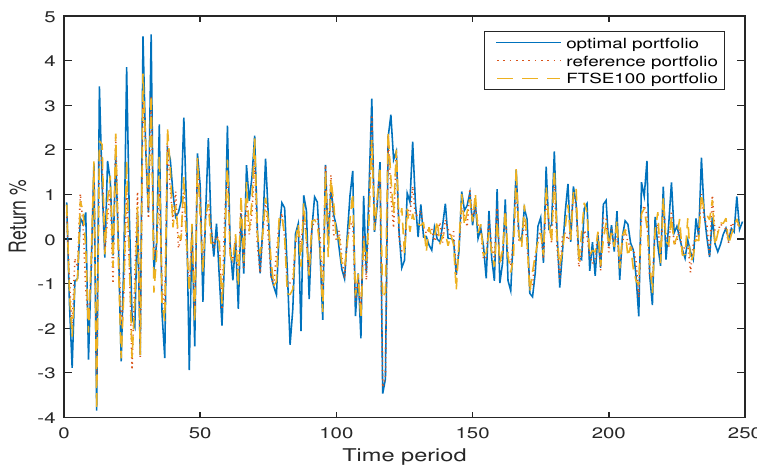
Figure 11. The return of optimal portfolio by ε BBO in each period with benchmark portfolio and the FTSE100 Index portfolio in X ∈ [ 0,0.1 ] of model (30).